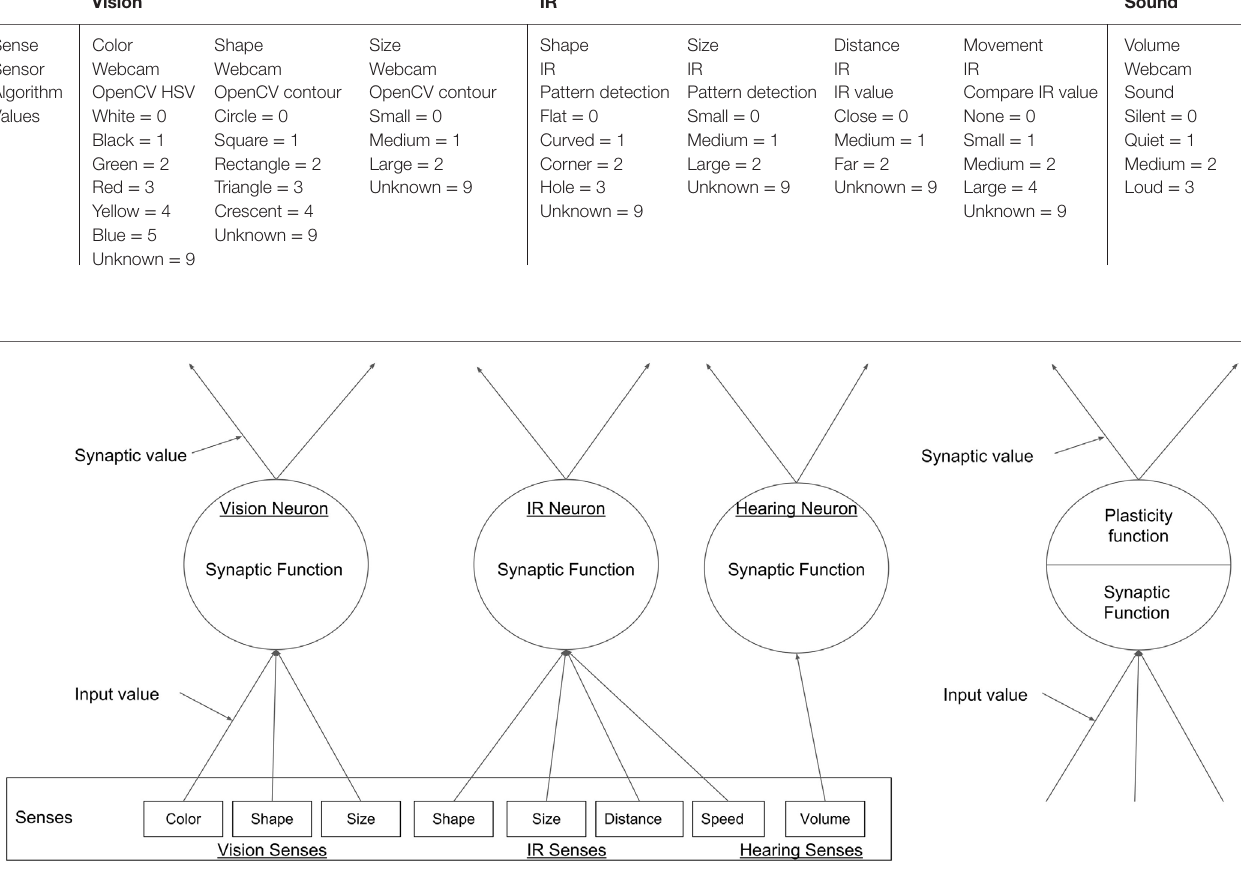
FigUre 3 | a generic example of the types of nodes in the enn, the three input nodes , each representing one of the robot’s senses can been seen on the left, and a hidden layer node on the right .